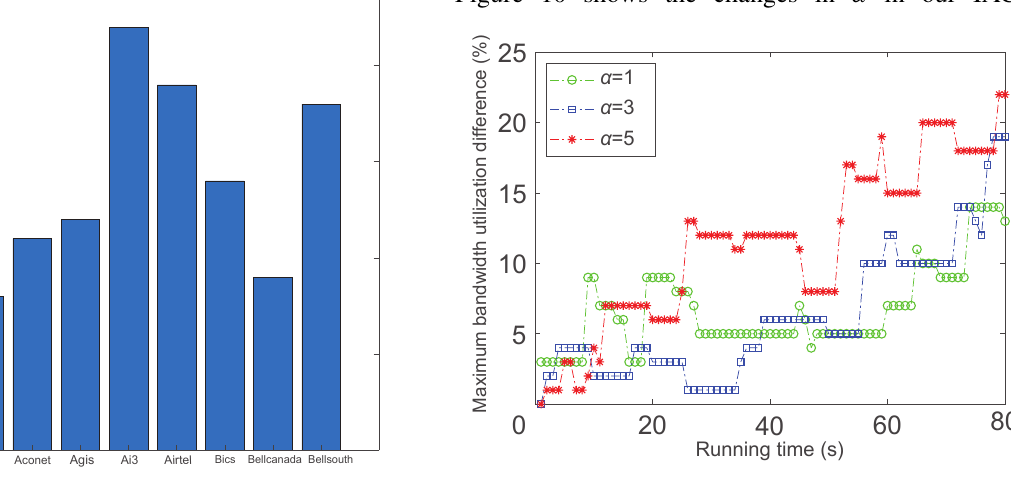
Fig. 8 Bandwidth difference for changing nodes.